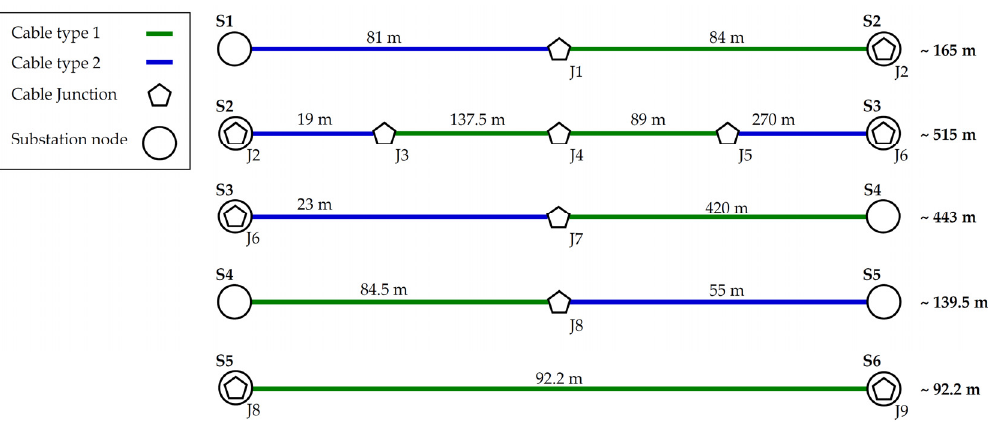
Figure 10. Diagram of the measured and simulated topology with full distance between substations.